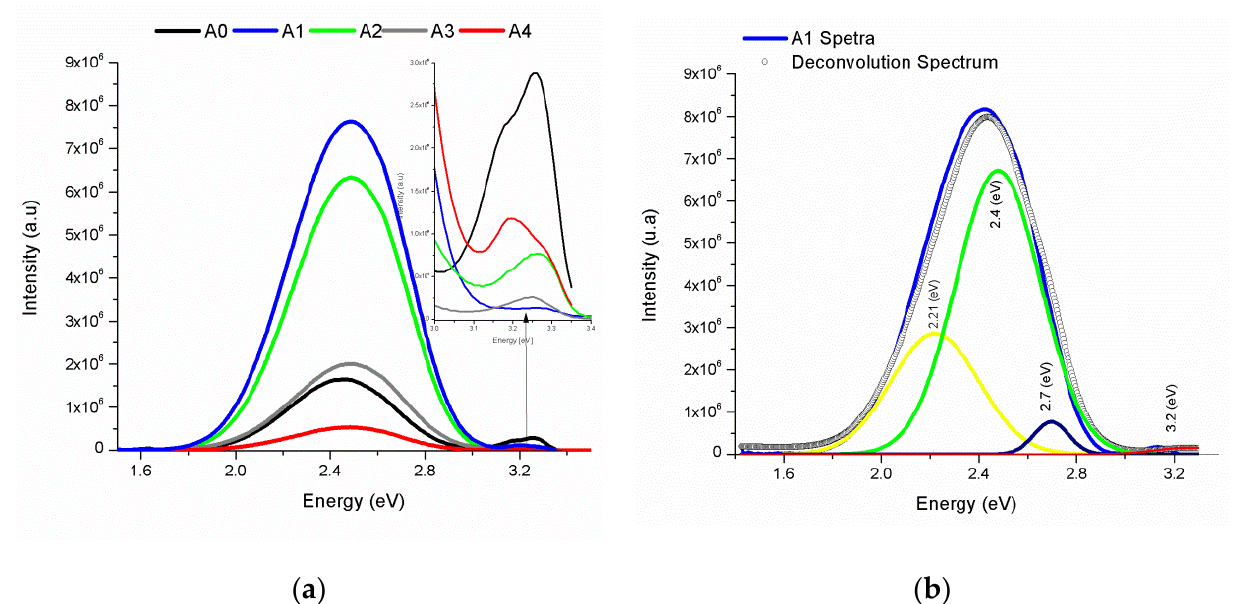
Figure 7. Photoluminescence spectra. The A0 spectrum is used as a reference, this sample was deposited without Ni. ( a ) PL spectra of the samples A1, A2, A3, and A4, deposited with ZnO:Ni at 500 °C, 400 °C, 350 °C, and 300 °C, respectively. The intensity of the emission peak ~2.48 eV of A1 is around four times the intensity peak of A0. The PL intensity (A2, A3, and A4) was reduced as the deposit temperature decreased. The effect of the temperature on the NBE band ~3.2 eV (upper right corner) is an intensity increment, lower in A1. ( b ) Deconvolution of the A1 PL spectrum, the peaks around 2.21 eV, 2.4 eV, 2.7 eV, and 3.2 eV are associated with different types of defects.